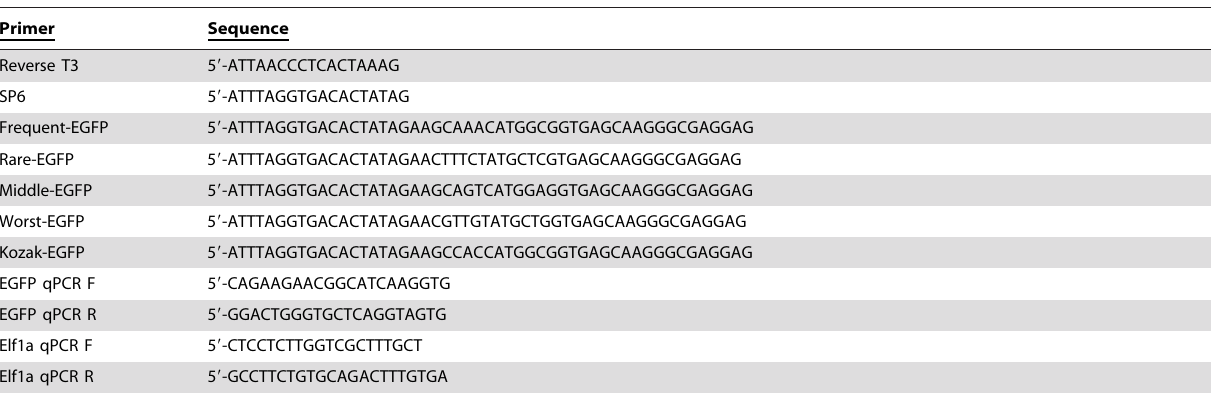
Table 1. Primer sequences.